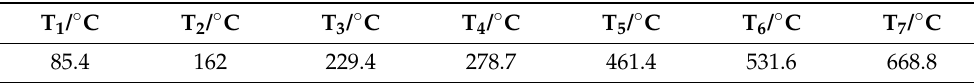
Figure 8. TG/DTG curve of Kerman coal. Table 14. Characteristic temperature points of Kerjian coal.